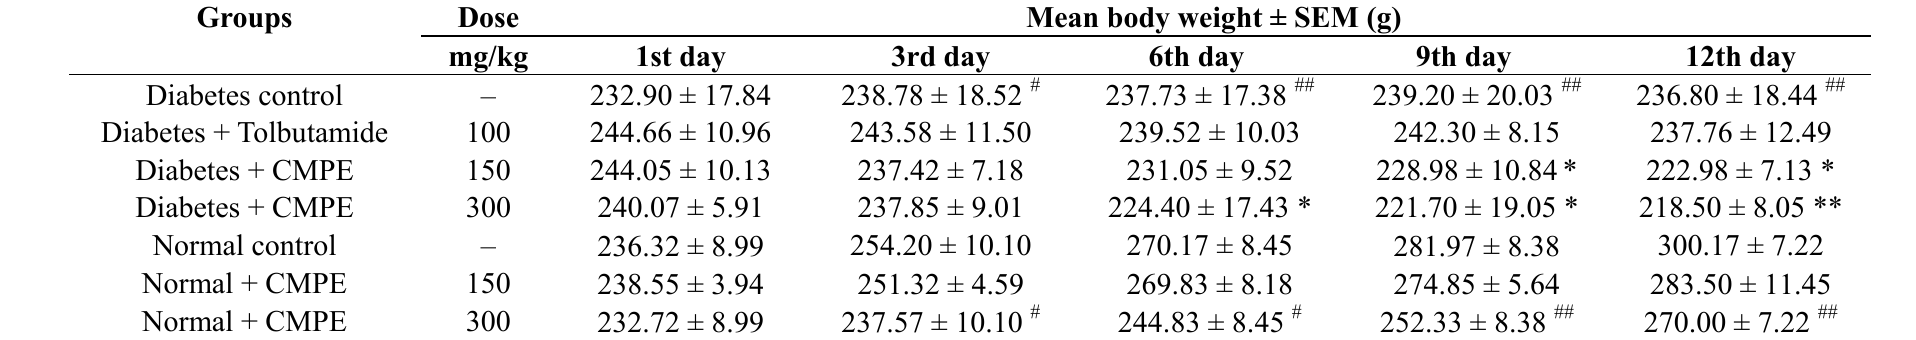
Table 1. Effects of CMPE on body weight of normal and STZ induced diabetic rats.